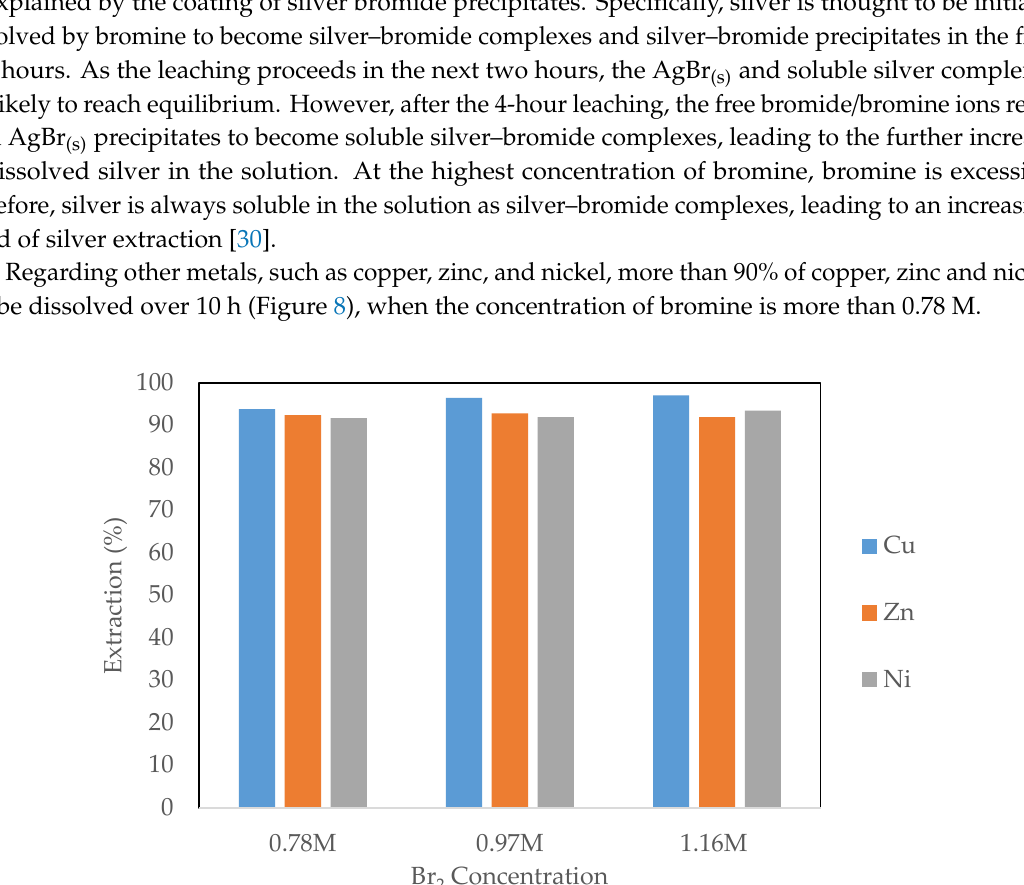
Figure 9. Dissolution of gold and silver at various concentrations of sodium bromide (0.78 M Br 2 , 23.5 °C and natural pH).